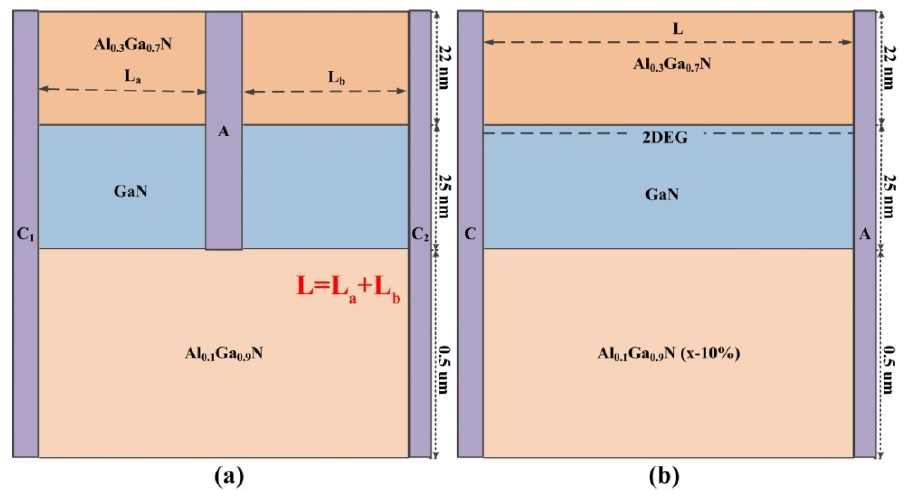
Figure 1. Schematic structures of GaN-based heterostructure Gunn diodes: ( a ) Grooved-anode diode, ( b ) Single-channel diode.